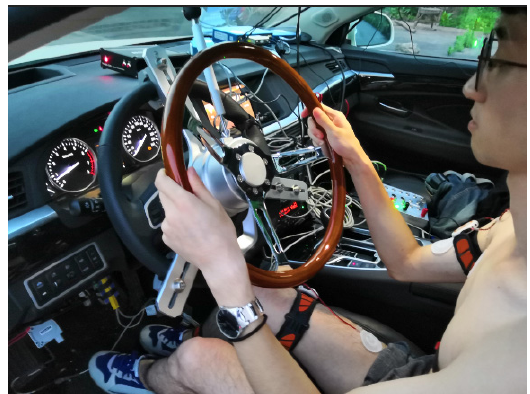
Figure 7. Driving experimental scenario.